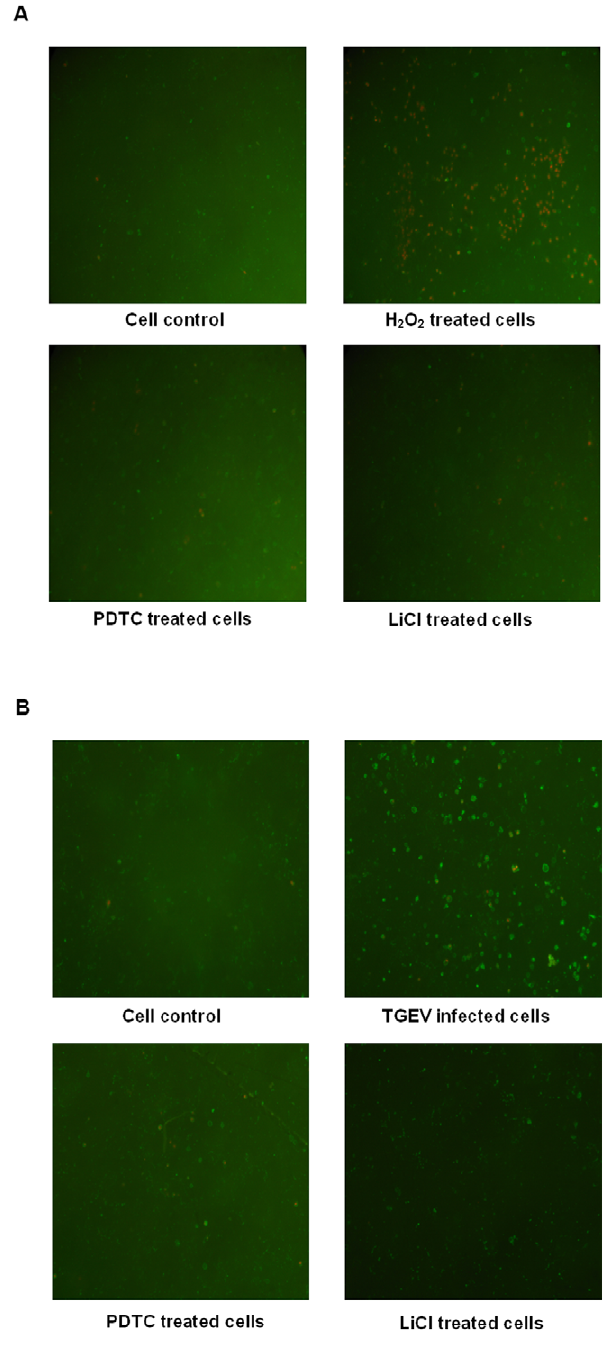
Figure 10. Immunofluorescence assays of the inhibitory effect of LiCl and PDTC on cell apoptosis. The cell apoptosis was induced by H 2 O 2 and the anti-apoptosis effect of LiCl was compared with a caspase inhibitor, pyrrolidine dithiocarbamate (PDTC). ST cells in 24-well plate were mock treated (cell control) or treated with 850 m M of H 2 O 2 alone (H 2 O 2 treated cells), or H 2 O 2 (850 m M) + PDTC (5 m M) (PDTC treated cells) or H 2 O 2 (850 m M) + LiCl (25 mM) (LiCl treated cells) at 37 u C for 4 h followed by staining with Annexin V and PI and subjected to immunofluorescence analysis (A). The inhibitory effect of both agents on TGEV induced cell apoptosis was evaluated. ST cells in 24-well plate were mock infected (Cell control) or infected with TGEV alone (TGEV infected cells), TGEV + PDTC (5 m M) (PDTC treated cells), TGEV + LiCl (25 mM) (LiCl treated cells) at 37 u C for 24 h. The titer of TGEV applied was at an MOI of 0.3 followed by Annexin V and PI staining and